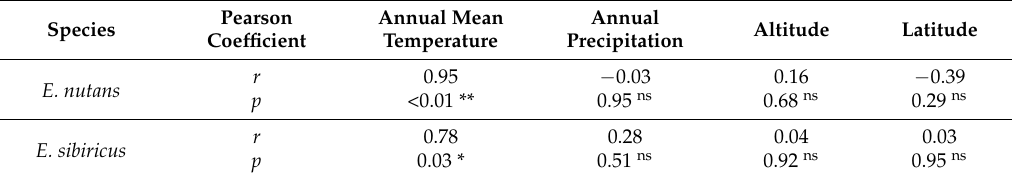
Table 6. Regression analysis between Nei’s genetic diversity (H) and environmental